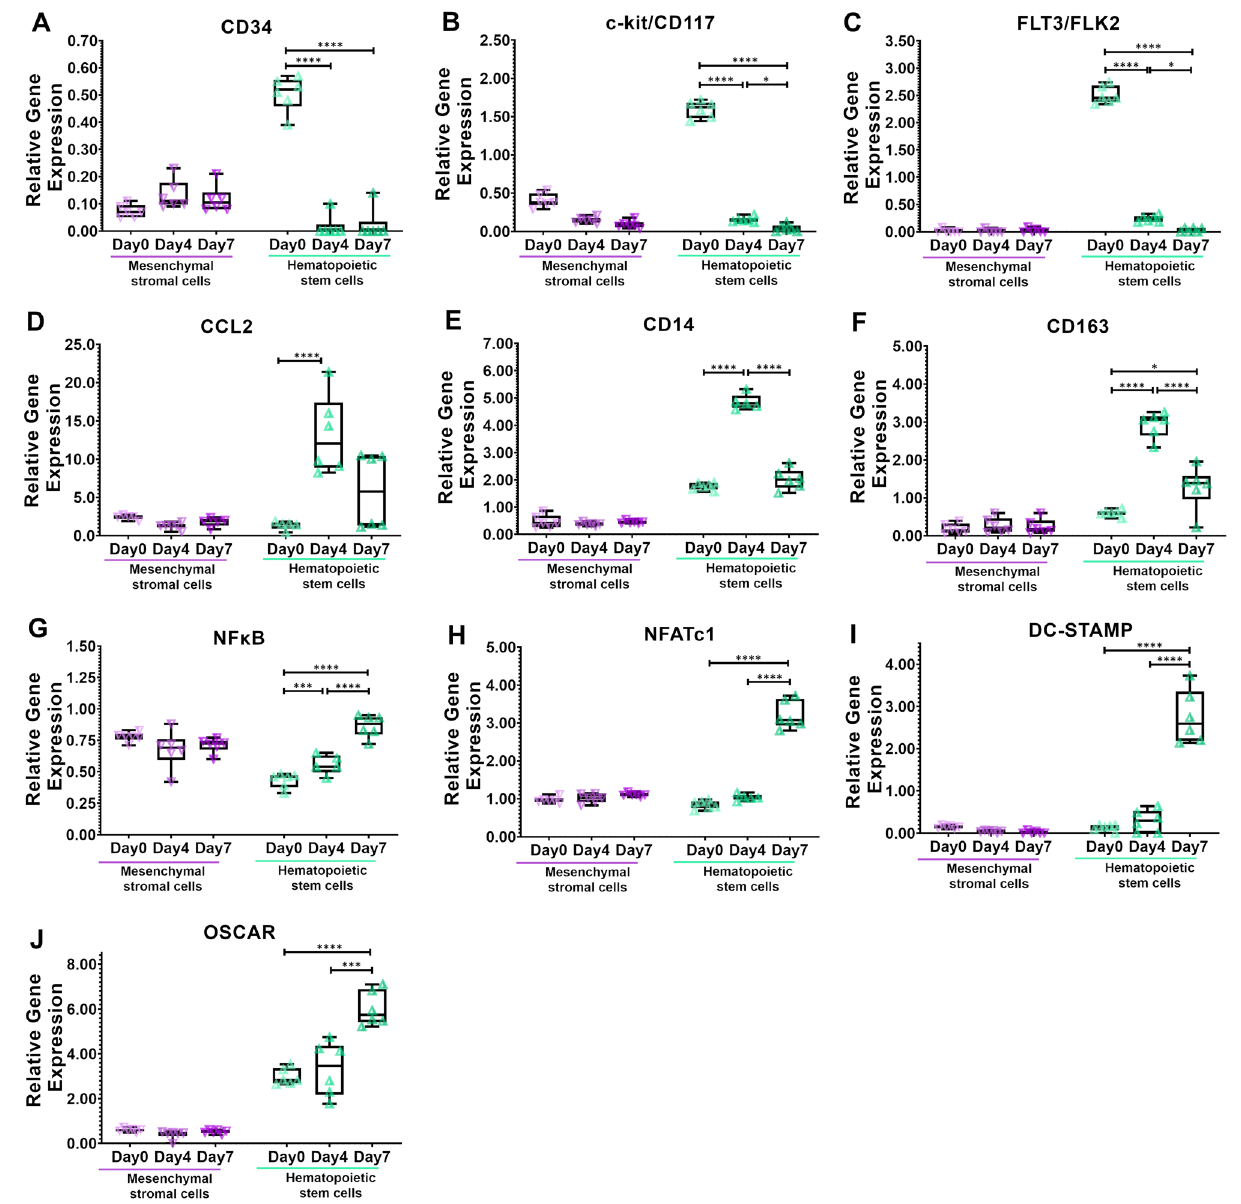
Figure 3. The induction of osteoclastic differentiation of hematopoietic stem cells was verified by gene expression analysis. ( A–C ) Hematopoietic stem cells (Day 0) were identified by an increased expression of ( A ) Hematopoietic Progenitor Cell Antigen (CD34), ( B ) KIT Proto-Oncogene, Receptor Tyrosine Kinase (ckit/ CD117), and ( C ) Fms Related Tyrosine Kinase 3 (FLT3 ( D–F ) Induction of osteoclastogenic differentiation into monocytes (Day 4) was verified by an increased expression of ( D ) C–C Motif Chemokine Ligand 2 (CCl2), ( E ) Monocyte Differentiation Antigen (CD14), and ( F ) Scavenger Receptor Cysteine-Rich Type 1 Protein M130 (CD163). ( G–J ) Induction of osteoclastogenic differentiation into pre-osteoclasts (Day 7) was verified by an increased expression of ( G) Nuclear Factor Kappa B Subunit 2 (NFκB), ( H) Nuclear Factor Of Activated T Cells 1 (NFATc1), ( I) Dendritic Cells (DC)-Specific Transmembrane Protein (DC-STAMP), and ( J ) Osteoclast Associated, Immunoglobulin-Like Receptor (OSCAR). *p<0.05, **p<0.01, ***p<0.001, ****p<0.0001, one-way analysis of variance with Bonferroni post hoc test. n = 6 individual hematopoietic stem cells (day 0, 1.3-fold, p = 0.0474) and expression was lower compared to pre-osteoclasts (day 7, 0.6-fold, p < 0.0001) (Fig. 3G). The differentiation into pre-osteoclasts was evaluated by genes known to be expressed in osteoclasts. Expres- sion of early gene changes on osteoclast differentiation, Nuclear Factor Kappa B Subunit 2 (NFκB) (Fig. 3G), and Nuclear Factor of Activated T Cells 1 (NFATc1) (Fig. 3H) was highest in pre-osteoclasts (day 7) compared to hematopoietic stem cells (day 0, 2.0-fold, p < 0.0001 and 3.8-fold, p < 0.0001, respectively) and monocytes (day 4, 1.5-fold, p < 0.0001 and 3.1-fold, p < 0.0001, respectively). Additionally, expression of Dendritic Cells